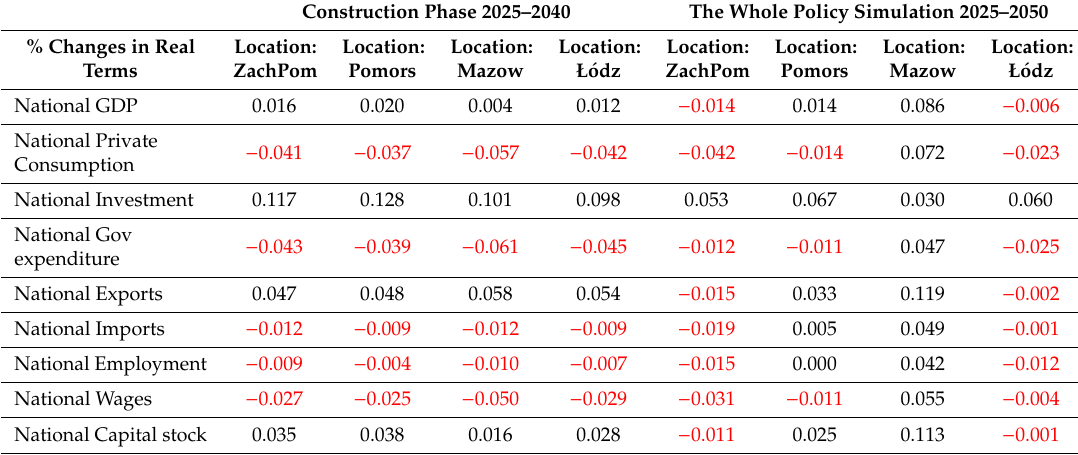
Table 3. Aggregated real impact of regional investment in nuclear power plant on national economy, for the construction phase and the total period. Di ff erence to the base scenario, percent by the end of the simulation